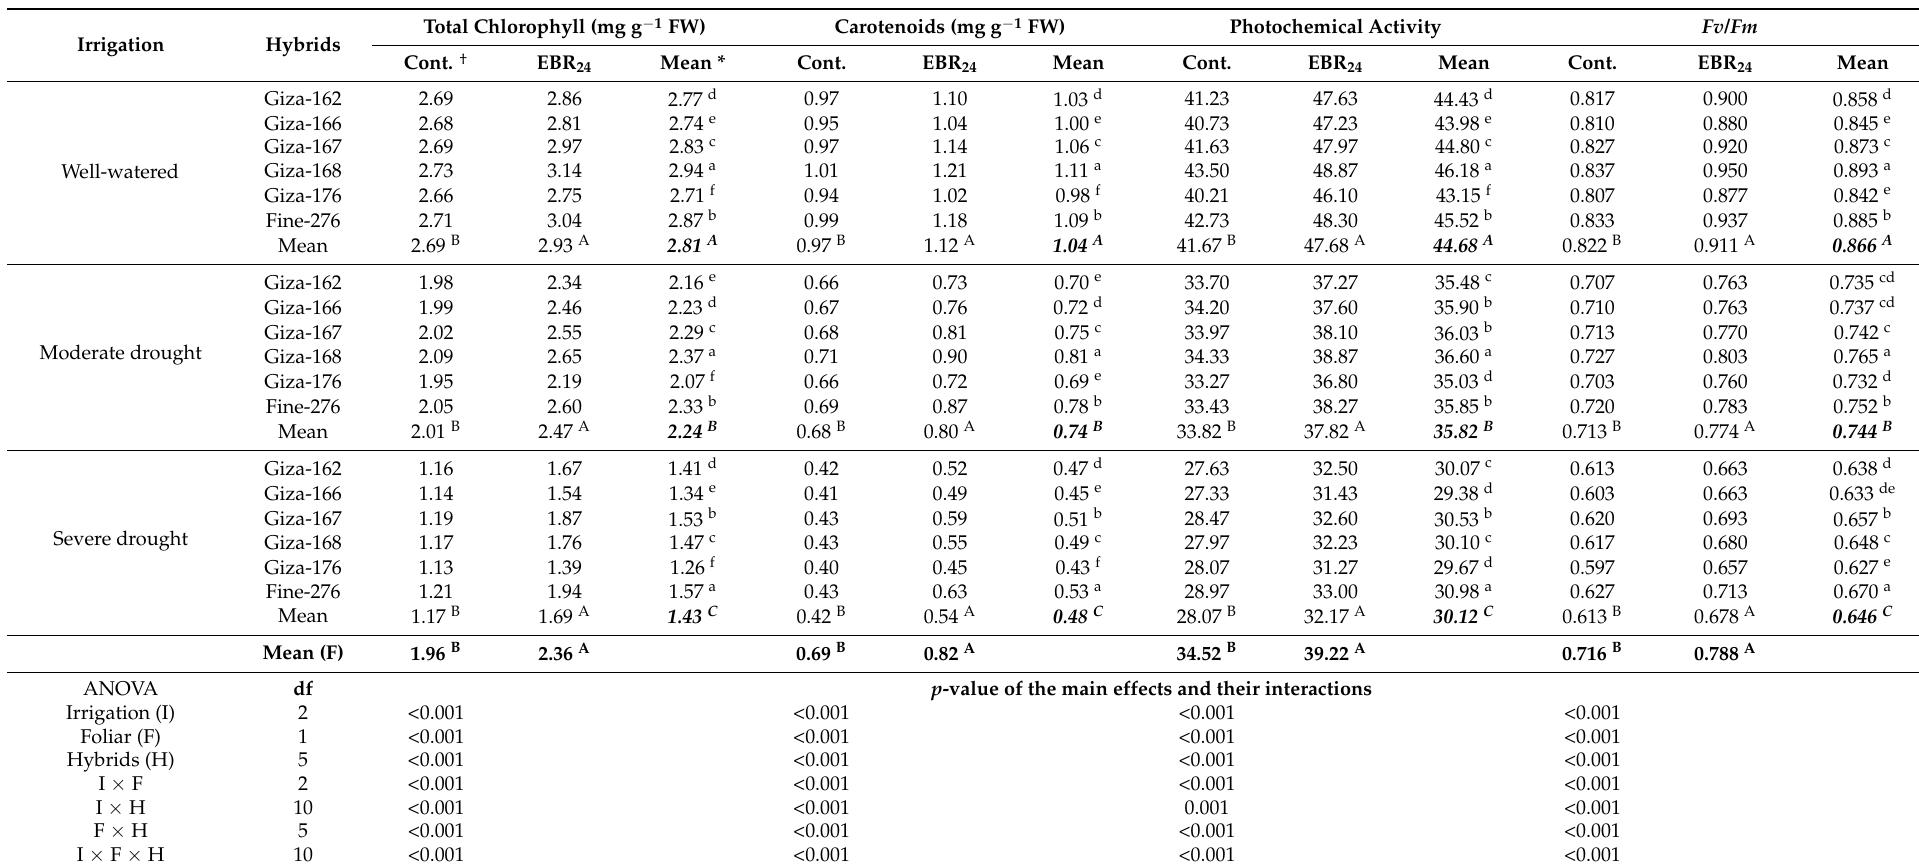
Table 2. Impact of 24-epibrassinolide (EBR 24 ) application on the total chlorophyll content, carotenoids, photochemical activity, and photosynthetic efficiency ( Fv/Fm ) of six maize hybrids grown under three irrigation regimes over the two growing seasons of 2018 and 2019.